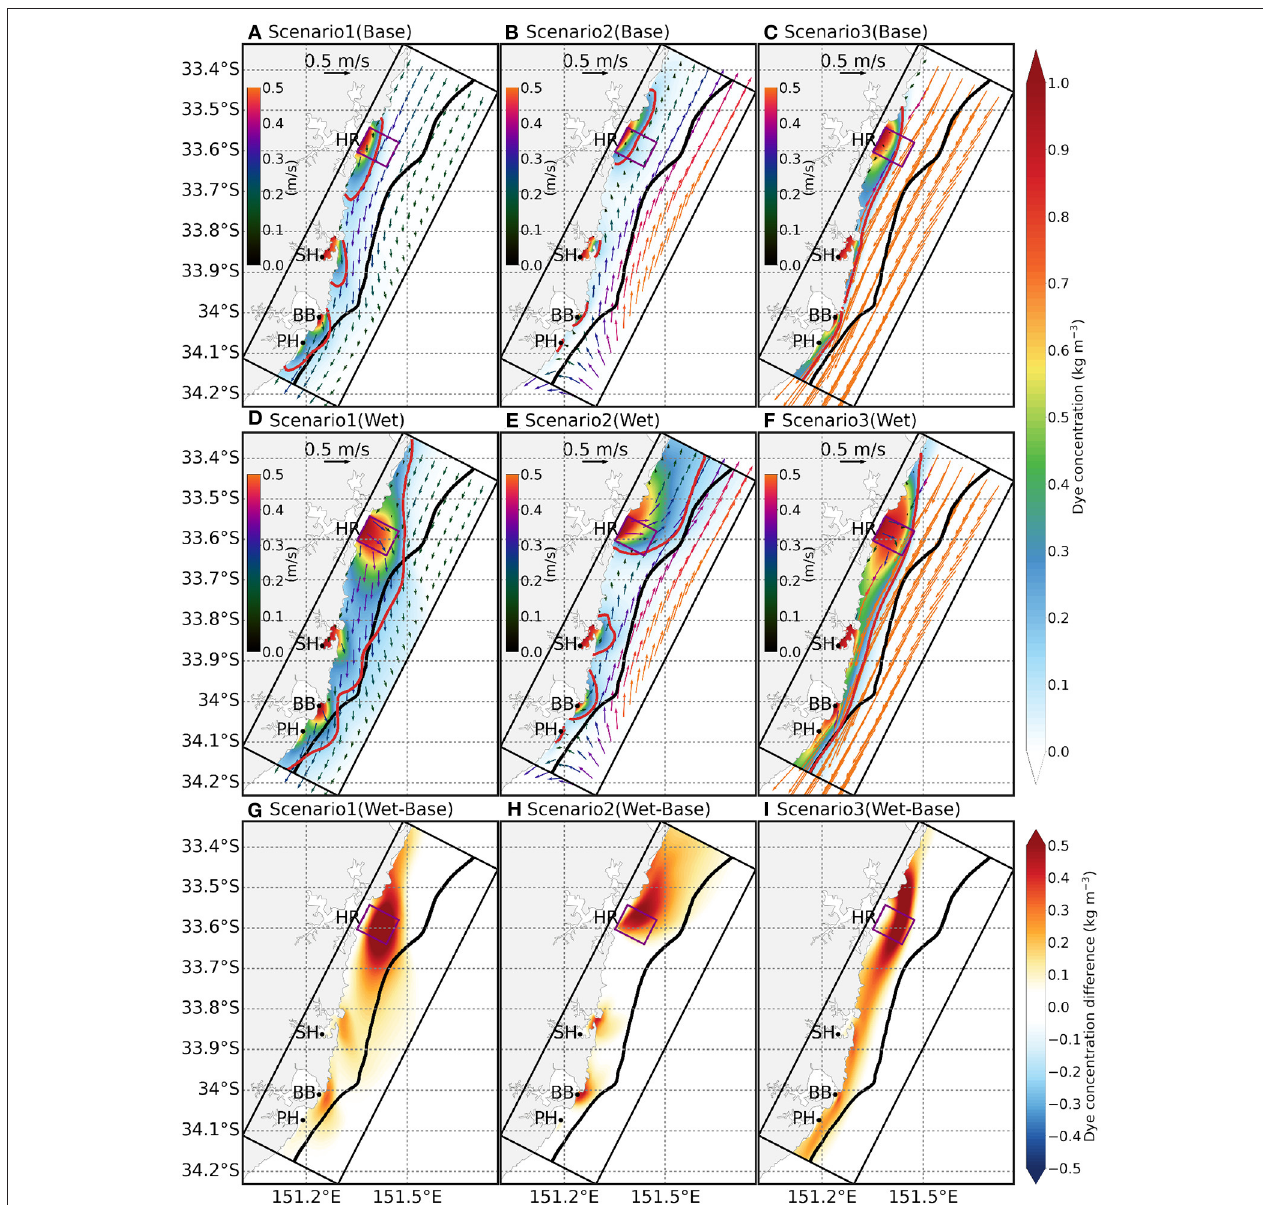
FIGURE 4 | Spatial distributions of dye concentration averaged over the first 4 days for each EAC scenario and their differences between the wet event and the base case. (A–C) Spatial distributions of dye concentration for EAC scenario 1, EAC scenario 2, and EAC scenario 3 in the base case. The solid black line shows the 100 m isobath, and the red line indicates the contour of 0.15 dye concentration. The vectors show the mean surface velocities. (D–F) Same as (A–C) , but for the wet event. (G–I) Differences of dye concentration for three EAC scenarios between the wet event (D–F) and the base case (A–C) .